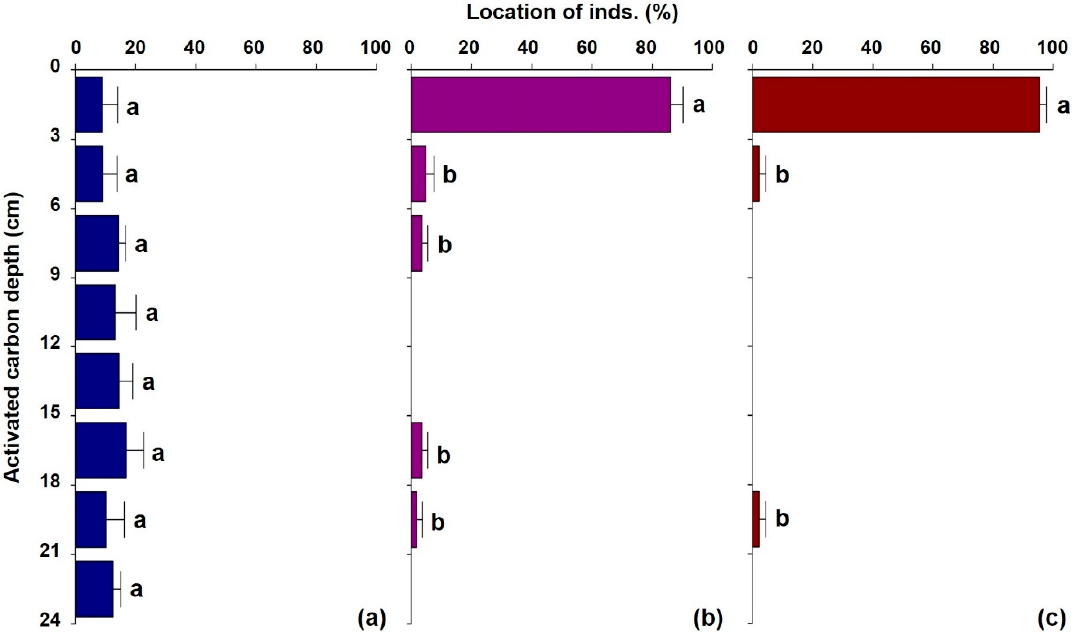
Figure 3. Distribution ratio of Glyptotendipes tokunagai larvae detected in 3-cm sections of GAC after 168 h of passage by larvae in the second instar ( a ), third instar ( b ), and fourth instar ( c ). Different letters indicate statistically significant differences at the 0.05 level in the Jonckheere–Terpstra test. Table 1. Results of Kruskal–Wallis and Jonckheere–Terpsta tests determining whether significant differences exist between the abundance of larvae at different depths in the granular activated car- bon (GAC) column. Instar Kruskal-Wallis Jonckheere–Terpstra Second NS 1 NS Third NS 0.009 Fourth 0.05 0.034